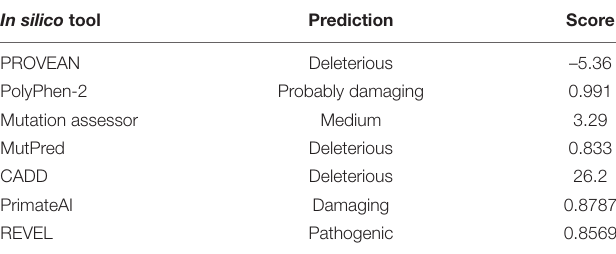
TABLE 2 | In silico analysis of the missense variant